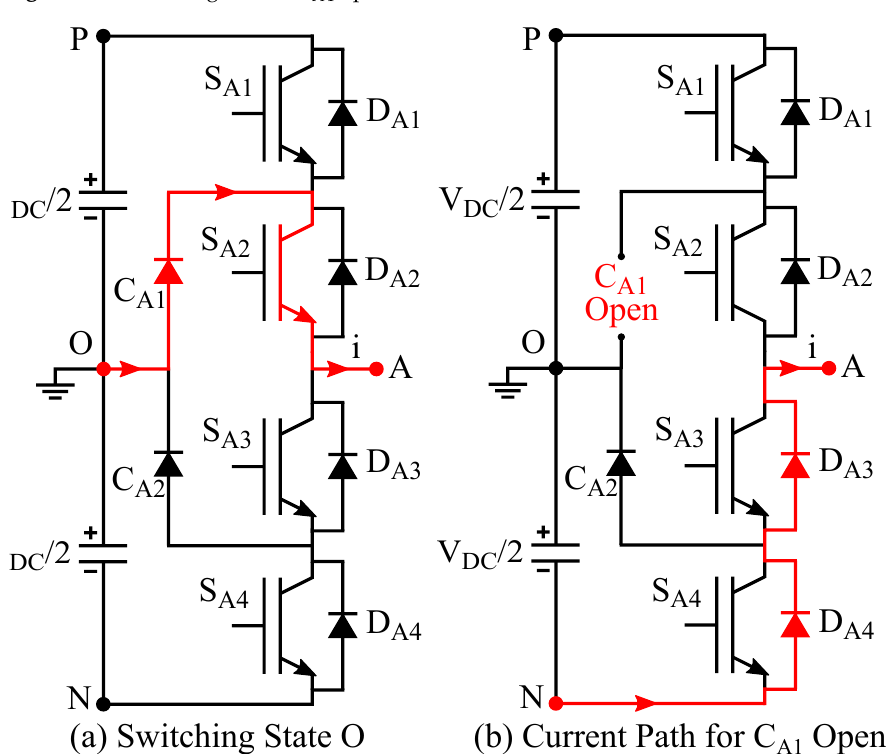
Figure 7. Circuit diagram for S A 4 open switch fault.